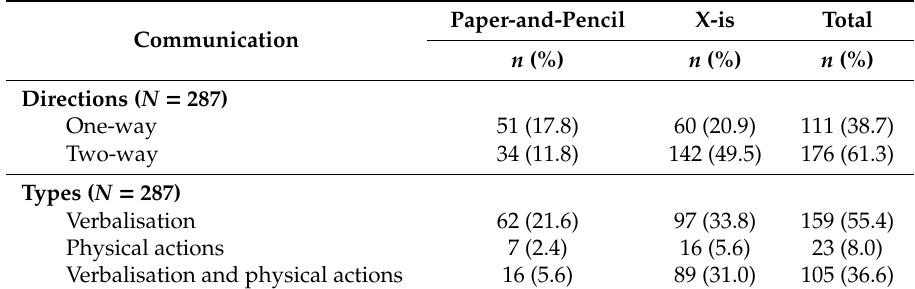
Table 3. Observed frequencies and percentages of peer communication episodes regarding directions and types by instructional